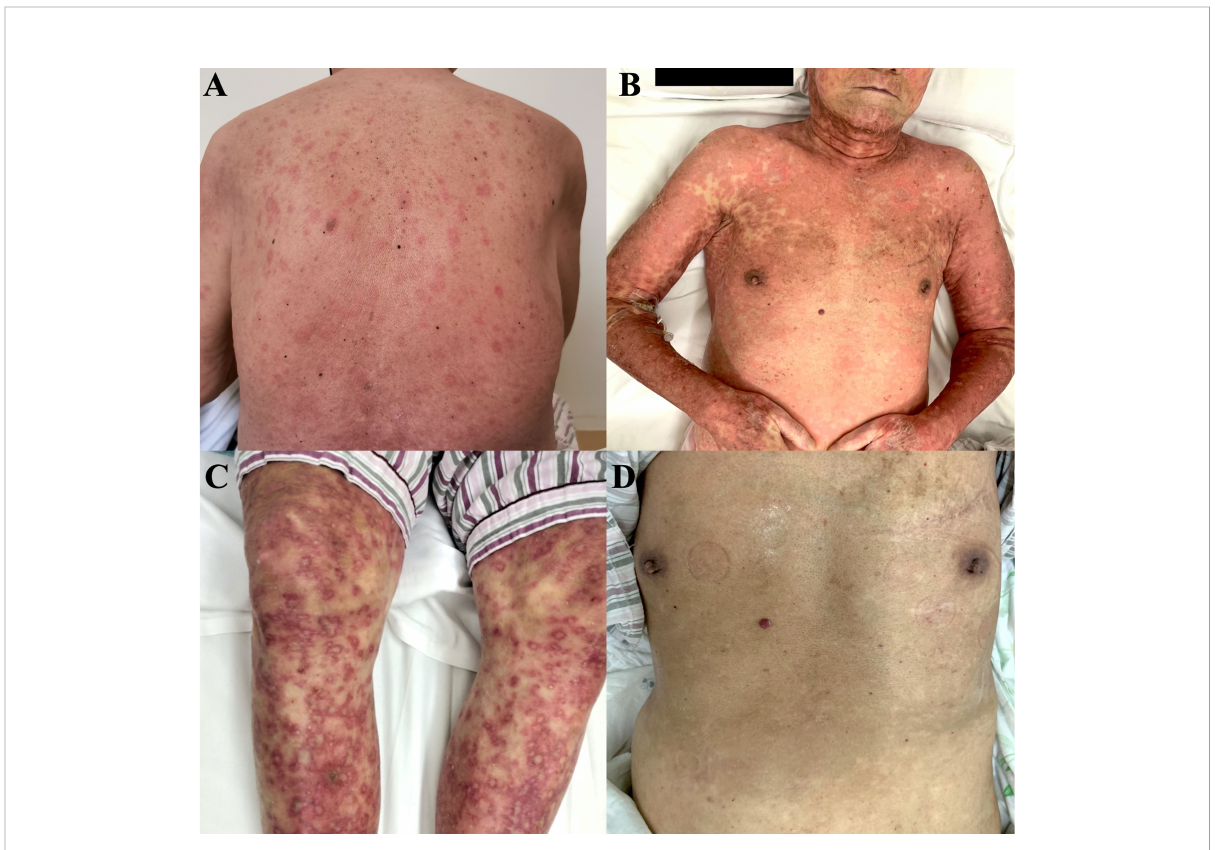
FIGURE 1 Photographs of skin lesion induced by sintilimab in an elderly patient with relapsed thymic carcinoma. (A) Rashes after fi rst cycle of treatment. (B, C) Rashes with blisters and skin detachment after second cycle of treatment. (D) Skin after recovery from severe toxic epidermal